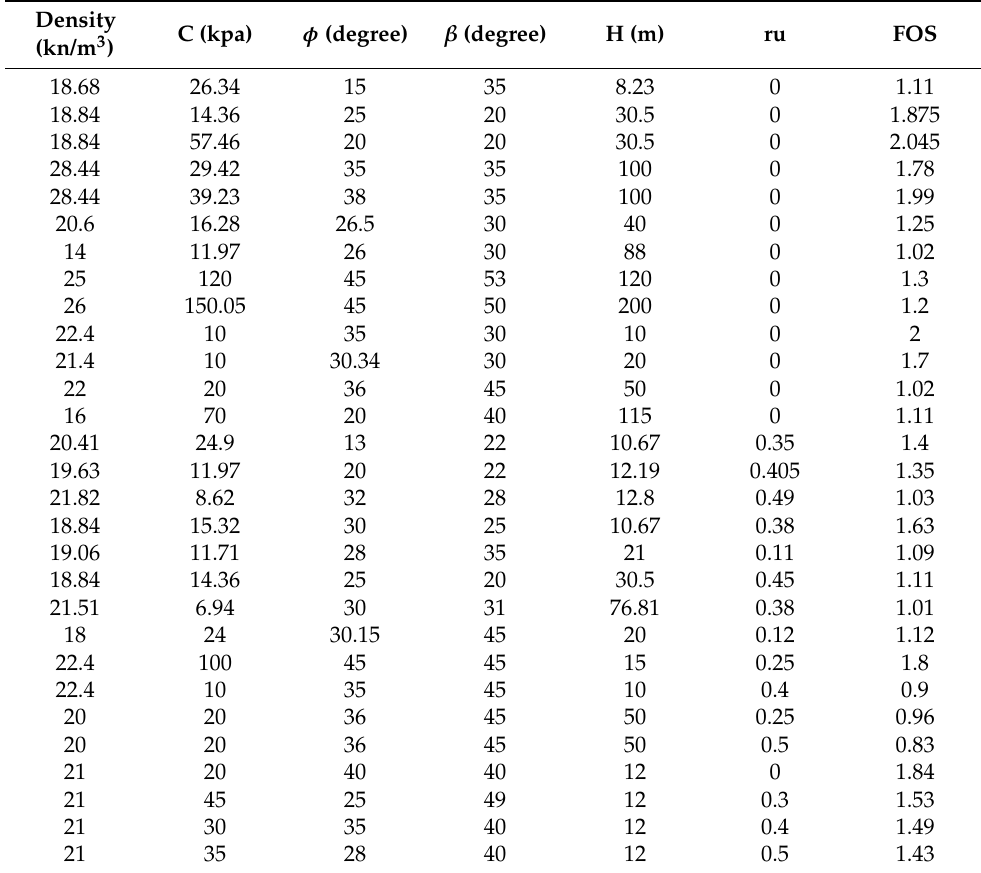
Table 3. The complete dataset used to develop